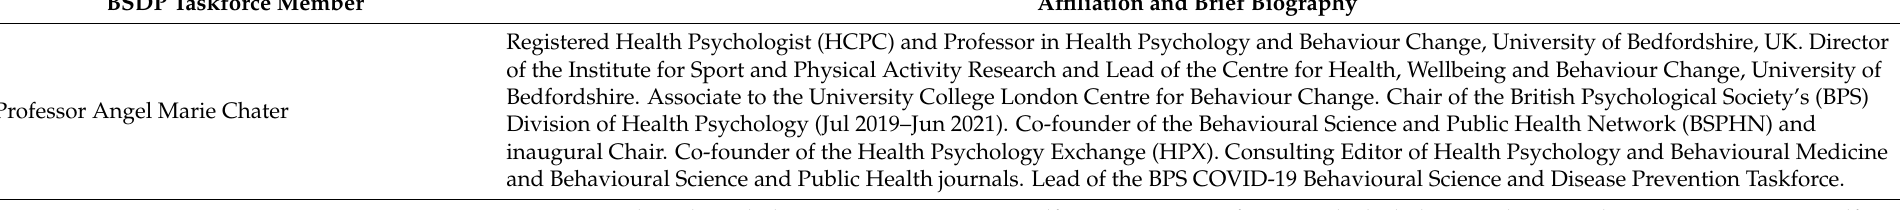
Table 2. Affiliations and biographies of each core member of the British Psychological Society COVID-19 Behavioural Science and Disease Prevention (BSDP) Taskforce. BSDP Taskforce